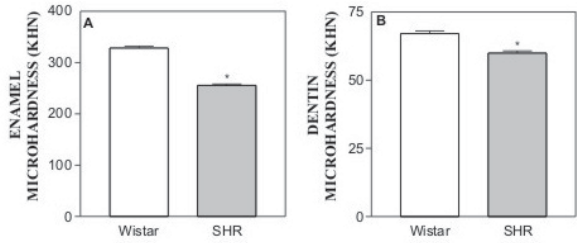
FIGURE 4- Microhardness of the mandibular incisors of Wistar and SHR offspring. The bars represent the mean ± SEM of (A) enamel microhardness of Wistar offspring (n=8) and SHR offspring (n=15) and (B) dentin microhardness of Wistar offspring and SHR